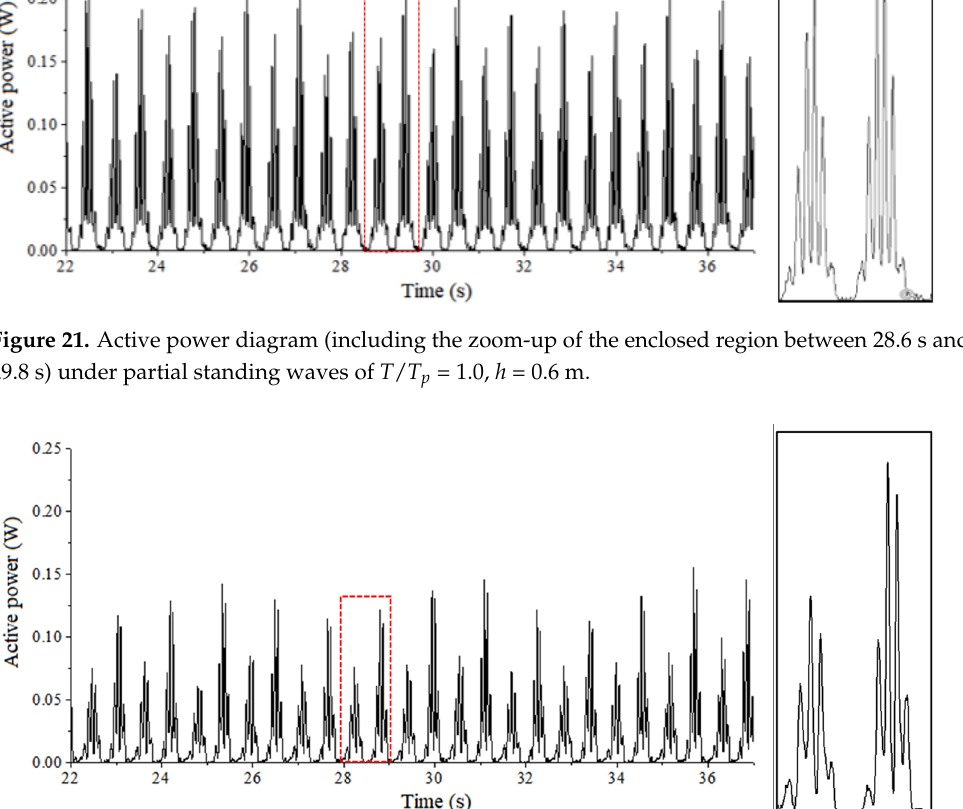
Figure 22. Active power diagram (including the zoom-up of the enclosed region between 28.0 s and 29.1 s) under fully standing waves of T / T p = 1.0, h = 0.6 m.